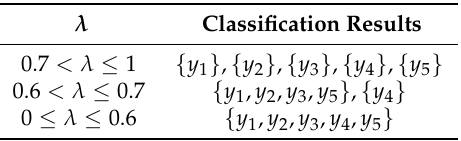
Table 5. Clustering algorithm in literature [18].